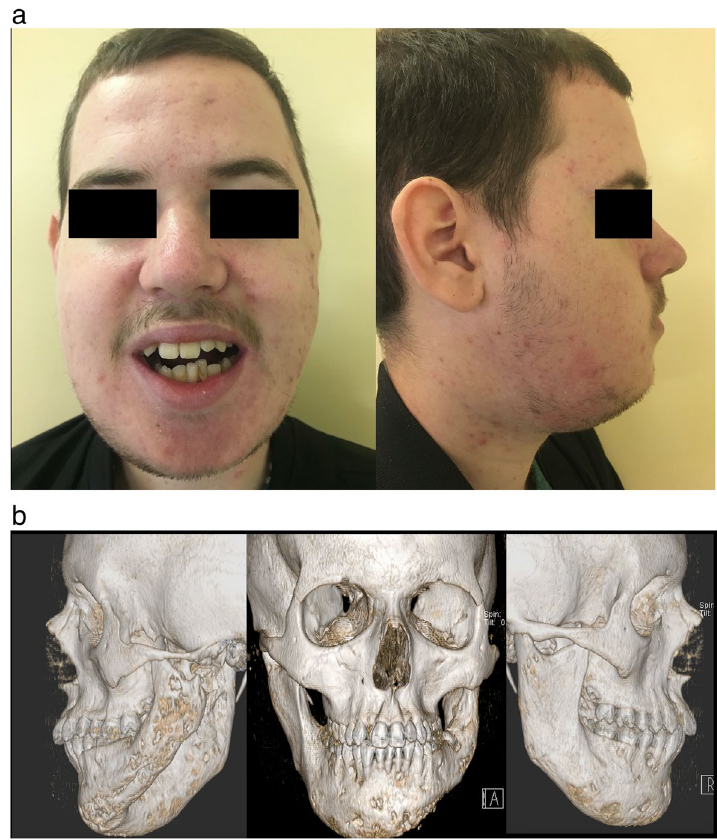
Fig. 1 a 20-year-old male patient affected by massive fibrous dysplasia of the mandible, facial deformity, and severe mouth opening restriction. b CT3D scans in front and lateral views